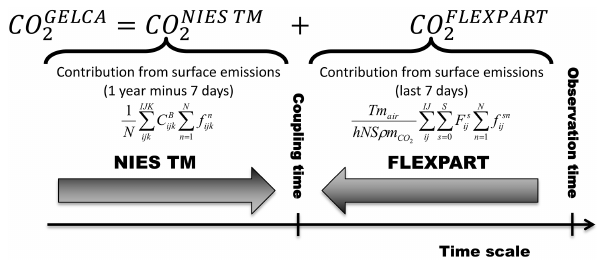
Figure 1. The computational scheme of the coupled